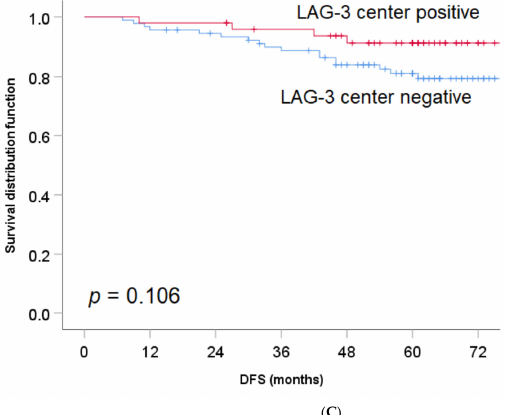
Figure 2. ( A ): The impact of LAG-3 expression on TILs on DFS in patients with stage II colon cancer (tumor center and tumor front). ( B ): LAG-3 expression on TILs at tumor front and its effect on DFS in stage II colon cancer. ( C ): LAG-3 expression on TILs in the tumor center and its impact on DFS in stage II colon cancer. The favorable association of LAG-3 expression on TILs either in the tumor front or tumor center with the outcome remained significant, even when we considered only MMR-proficient colon cancers (5-year DFS 90.2% versus 67.9%, HR 0.30, 95% CI 0.11–0.83, J. Pers. Med. 2021 , 11 , x FOR PEER REVIEW p = 0.014; Figure 3A). Again, the favorable correlation between LAG-3 positive TILs and outcome among MMR-proficient tumors was limited to those localized at the tumor front (Figure 3B), whereas no association with outcome could be observed among LAG-3 positive versus LAG-3 negative TILs in the tumor center (5-year DFS 90.6% versus 75.7%, HR 0.35, 95% CI 0.12–0.99, p = 0.039 and 90.4% versus 80.6%, HR 0.44, 95% CI 0.13–1.56, p = 0.192, respectively; Figure 3C). Due to the low number of events in our cohort of stage II colon cancer, we were not able to conduct a multivariate analysis. However, after adjustment for the pT stage in a bivariate analysis, the favorable effect of LAG-3 expression on DFS remained significant (HR 0.35, 95% CI 0.15–0.83, p = 0.017).